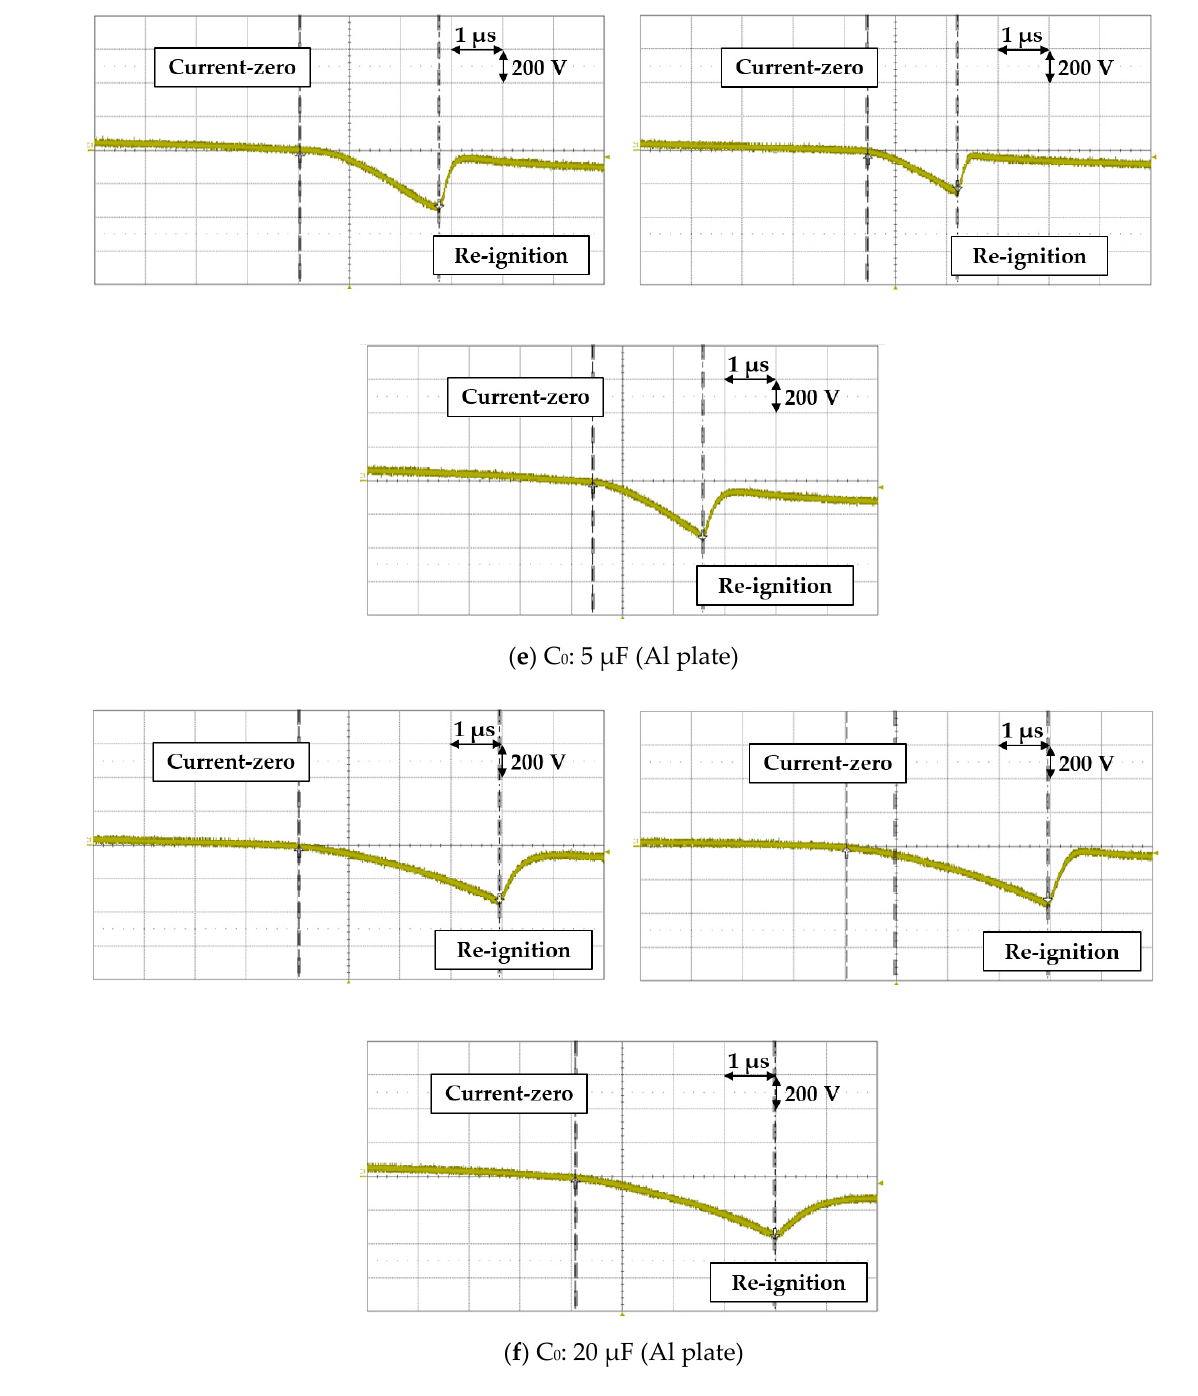
Figure 5. Experiment waveform (according to plate materials).